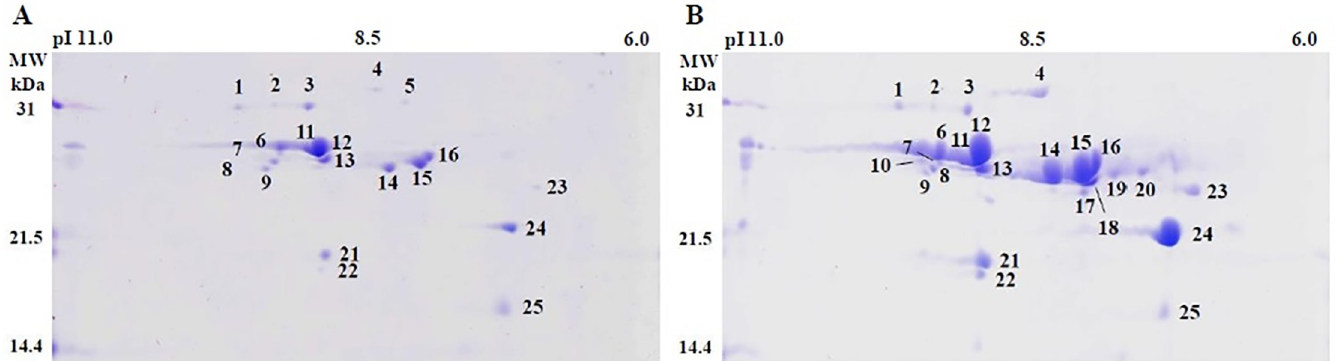
Fig 3. Two-dimensional gel analysis of total prolamin extracts from adlay young (A) and mature (B) seeds.